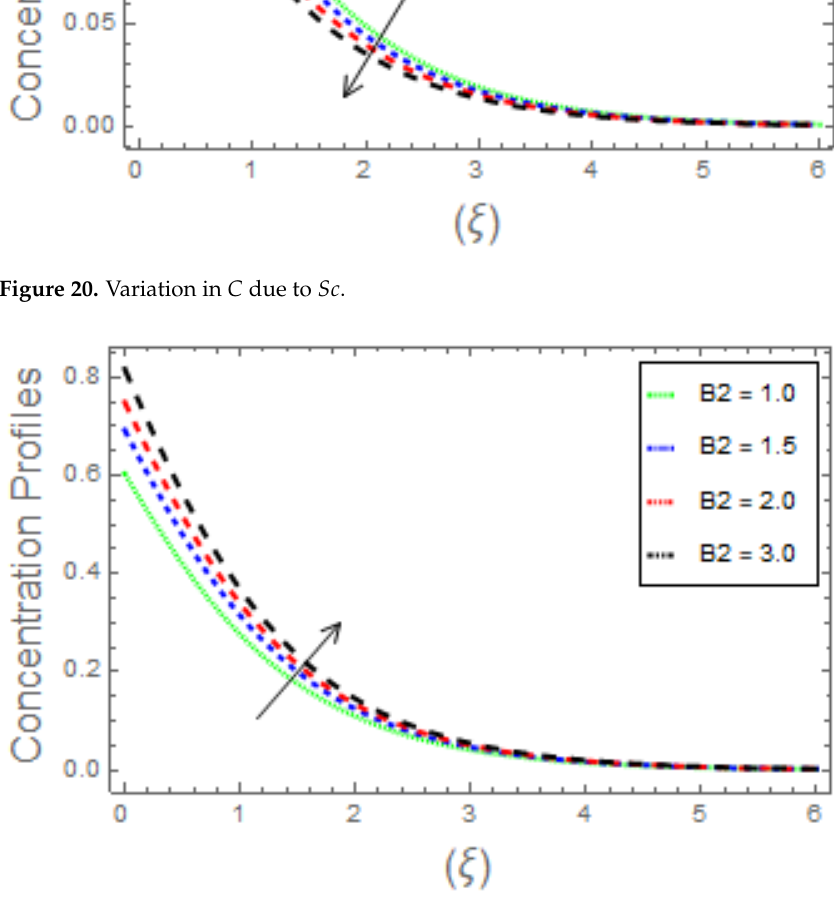
Figure 21. Variation in C due to B 2